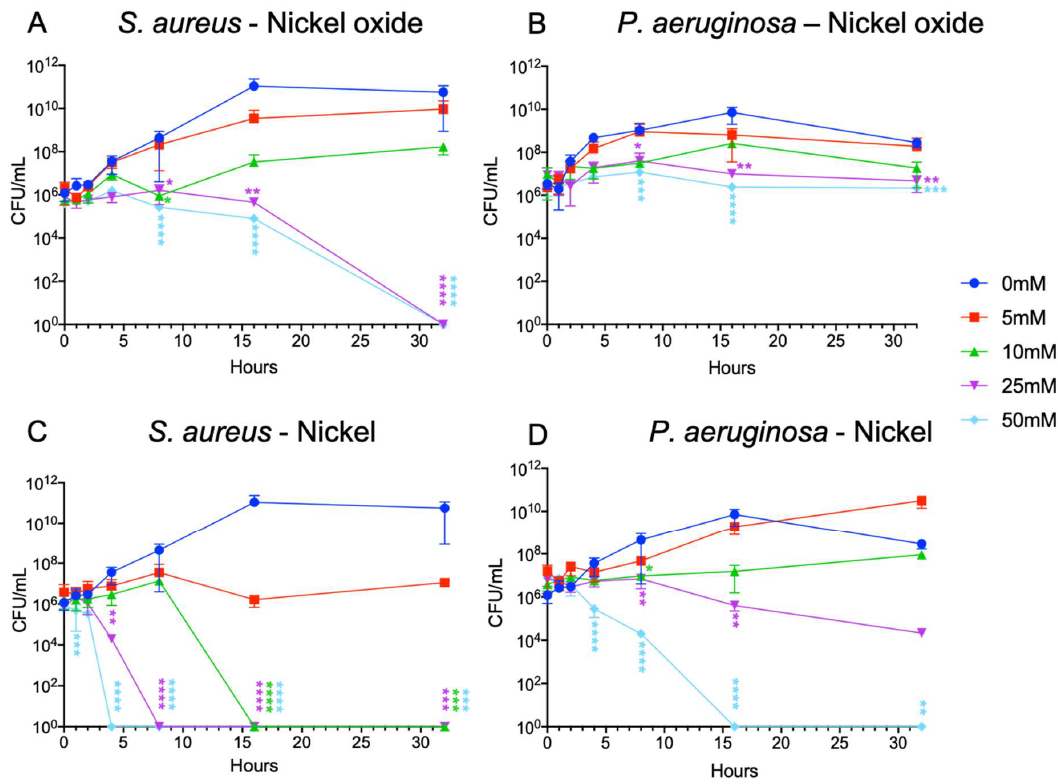
Figure 3. Time kill assay of Staphylococcus aureus ( A , C ) and Pseudomonas aeruginosa ( B , D ) cultured with different concentrations of nanoparticles. S. aureus could survive in low concentrations (5 and 10 mM) of nickel oxide without a significant effect, but at a nickel oxide concentration of 25 mM or more, growth inhibition was observed, and after 32 h, all bacteria were dead ( A ). In contrast to S. aureus , P. aeruginosa could survive at higher concentrations of nickel oxide. The bacteria entered the exponential growth phase for the first 8 h, but then cell division was reduced and the bacteria still survived ( B ). Nickel showed high toxicity to S. aureus at 10 mM, and the bacteria were eliminated after 16 h. At higher concentrations, e.g., 25 mM, the cells were dead after 8 h, and at 50 mM, after 4 h ( C ). P. aeruginosa showed provocative behavior in the presence of nickel at low levels. At 5mM nickel, after 16 h, the division of the bacteria still took place and remained in the expansion phase. At 10 mM, P. aeruginosa had a slight increase and reached the end point of the control after 32 h. At 25 mM, a decrease in the number of bacteria was observed after 8 h. After 32 h, the number of live cells was reduced by a factor of 10. The highest nickel concentration used in this study (50 mM) showed a toxic effect, such that a significant decrease in the cell number was observed after 2 h, and all cells died after 16 h (D). Definition of statistical significance: GP: 0.1234 (ns), 0.0332 (*), 0.0021 (**), 0.0002 (***), 0.0001 (****).